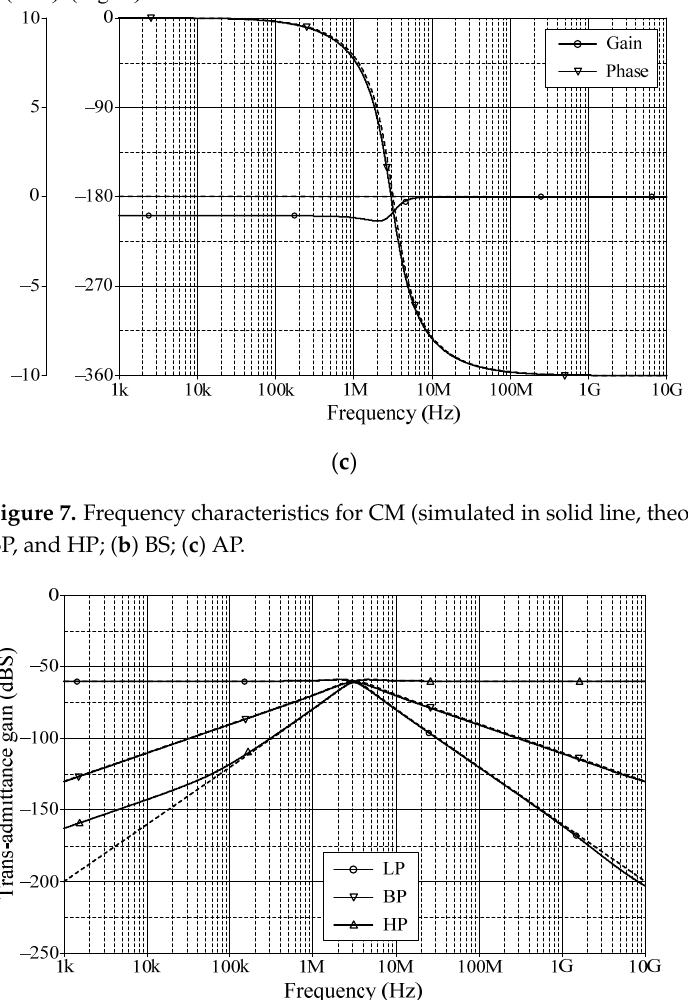
Figure 8. LP, BP, and HP frequency characteristics for TAM (simulated in solid line, theoretical in dashed line).